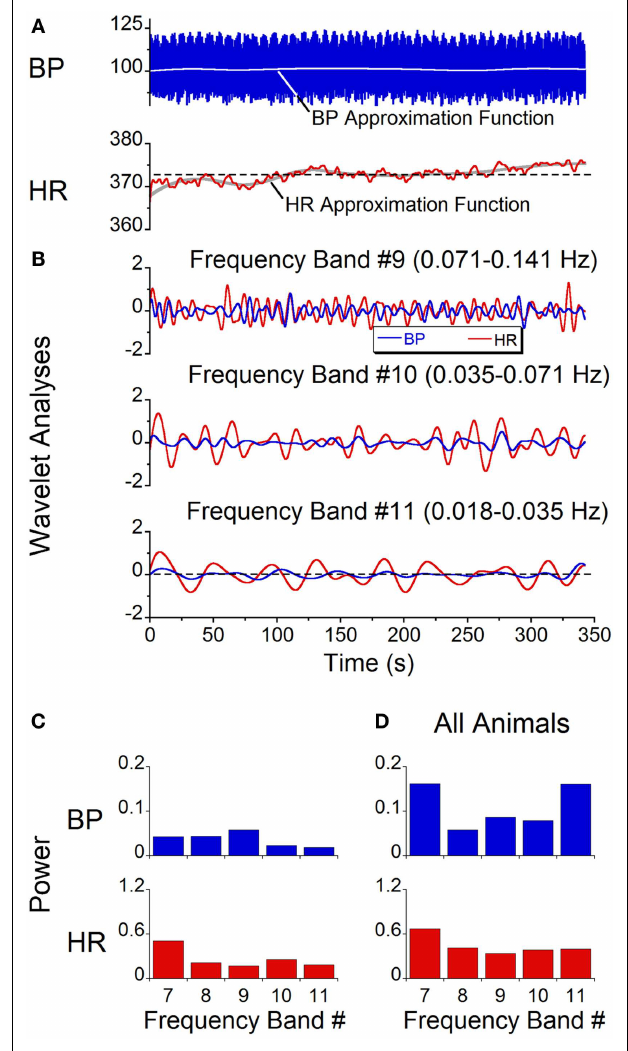
FIGURE 6 | Spontaneous oscillations in BP and HR with no vestibular stimulus . (A) BP and HR recordings.The gray lines represent approximation function median values of BP (blue trace) and HR (red trace). (B) Wavelet decomposition of signals shown in (A) into individual frequency bands. BP (blue traces) is in millimeter of mercury and HR (red traces) is in beats per minute. (C) Power of individual bands of BP (blue) and HR (red) obtained from data shown in (A) . (D) Average power of BP (blue) and HR (red) across frequency bands 7–11 in all six rats.